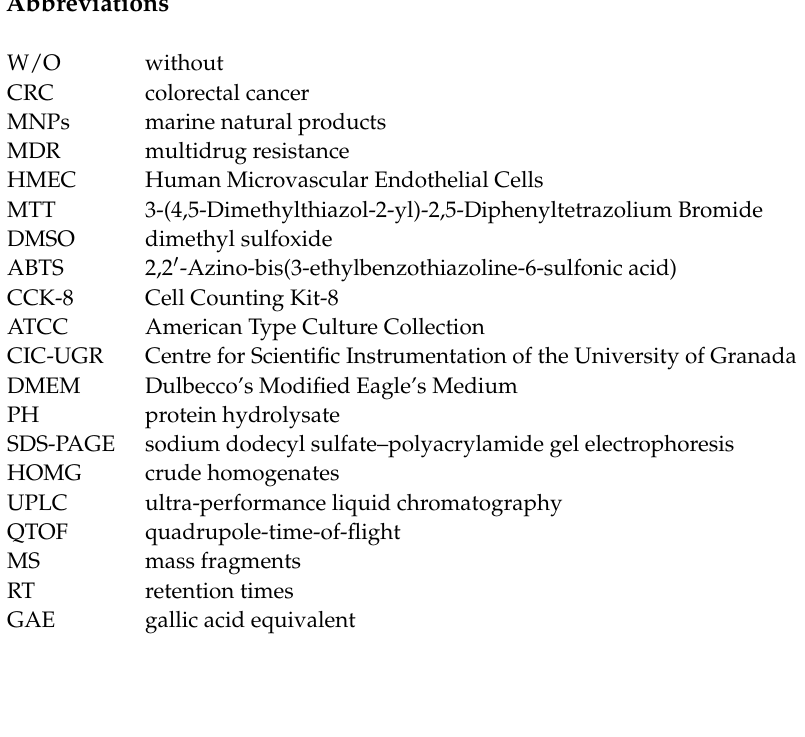
Figure S2. Antiproliferative activity of the protein hydrolysates on colon cells. Figure S3. Effect of high temperatures and freeze–thaw cycles on the antiproliferative activity of the crude homogenates (HOMG) on the T84 human colon cancer cell line. Figure S4. Antiproliferative activity of the digestion products from the crude homogenates on the T84 cell line. Figure S5. Wound healing assay of the crude homogenates (HOMG) on the T84 human colon cancer cell line. Figure S6. Multicellular tumor spheroids (MTS) from MC38 treated with the crude homogenates. Table S1. IC 50 value of colon cells treated with the ethanolic extracts (EXTOH) obtained from Anemonia sulcata with (W) and without (W/O) its